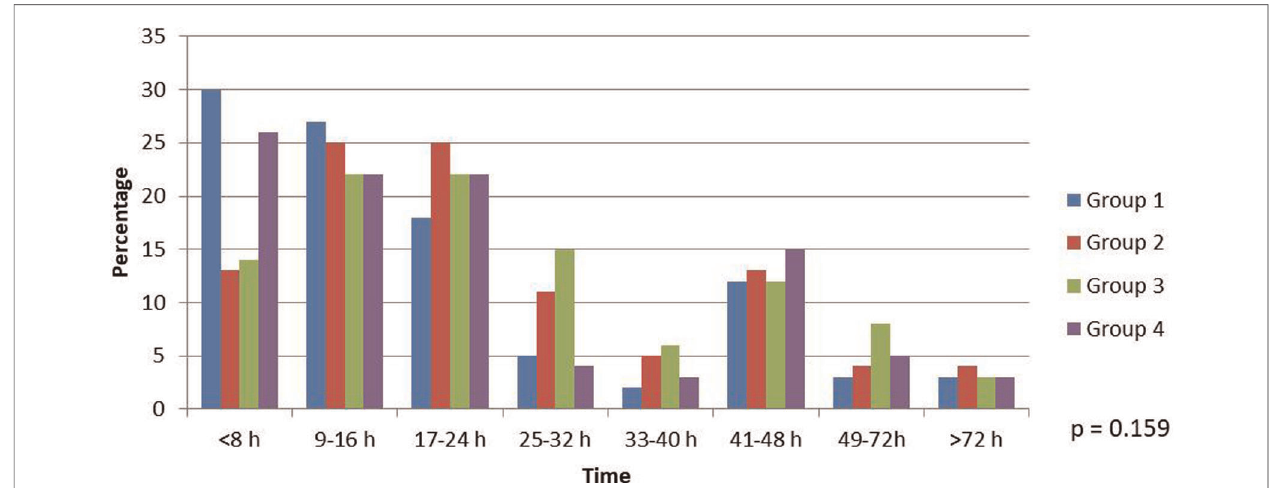
FIGURE 1 | Time from onset of symptoms to fi rst contact with healthcare provider in suspected acute appendicitis